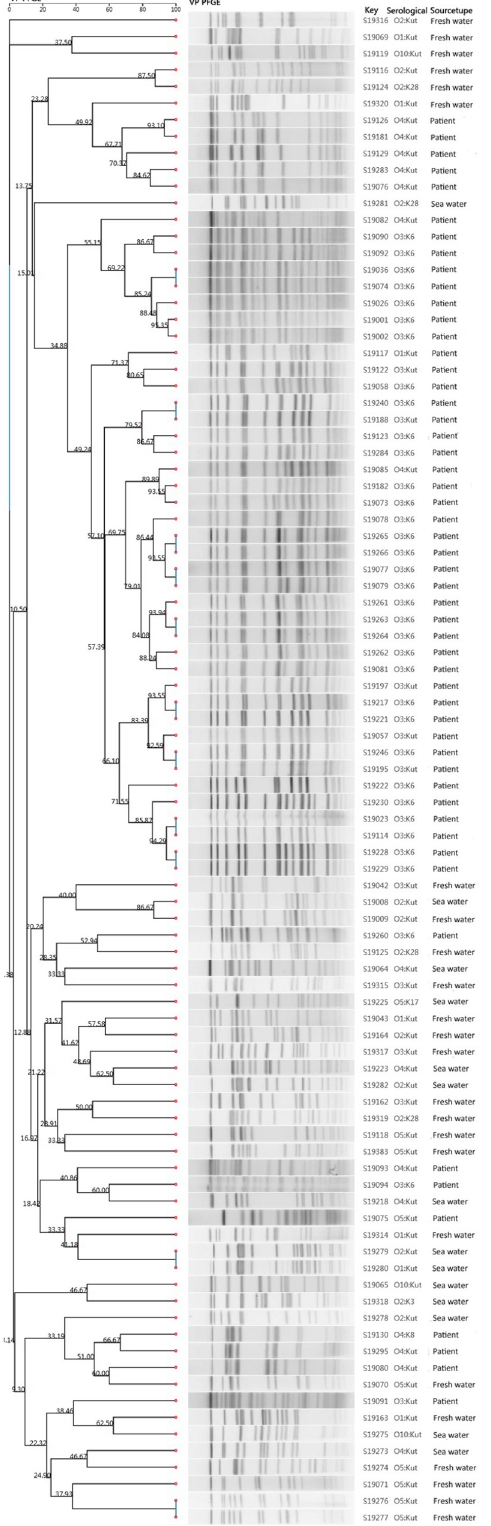
Fig 1. PFGE of Not I-digested genomic DNA of selected clinical and environmental V . parahaemolyticus isolates. Strain identification number, seromarkers, and sample source.